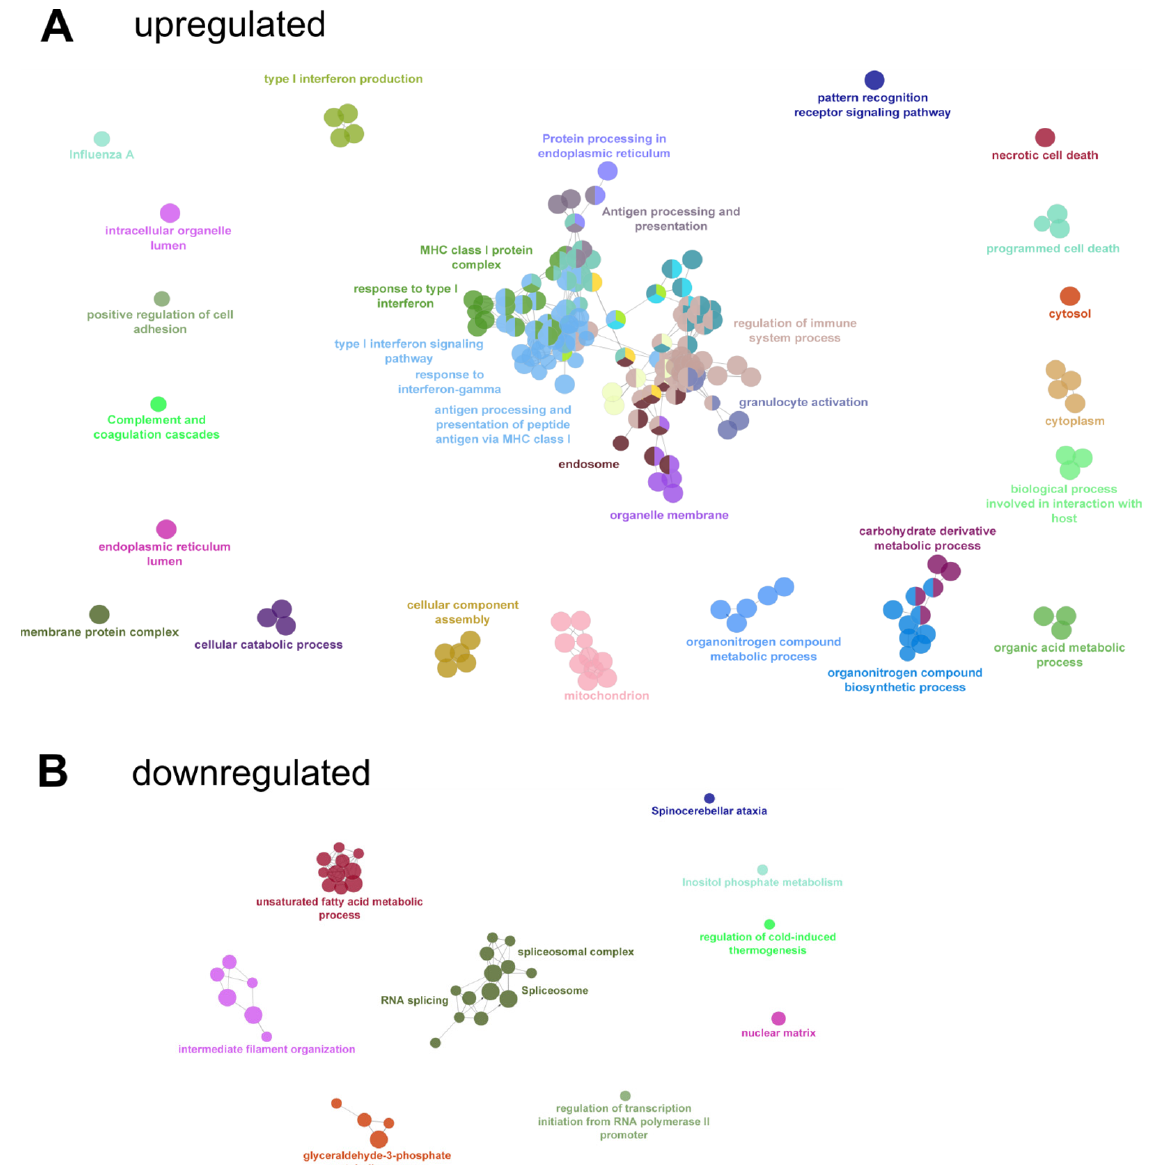
Figure 8. GO network analysis. Early (1 dpi, 2 dpi) and late (9 dpi, 12 dpi) stages were compared and upregulated ( A ) or downregulated ( B ) genes at late stages were subjected to GO-term enrichment analysis followed by network analysis with the ClueGO package of Cytoscape. Related GO-terms for clusters are labeled with one representative GO-term name from the cluster. Analysis parameters and detailed results can be found in Tables S2 and S3.